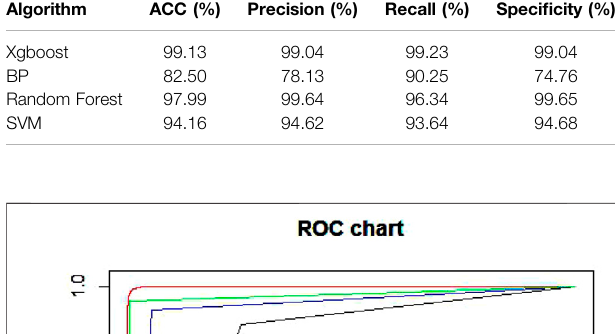
TABLE 4 | Comparison of the Xgboost with alternative models.